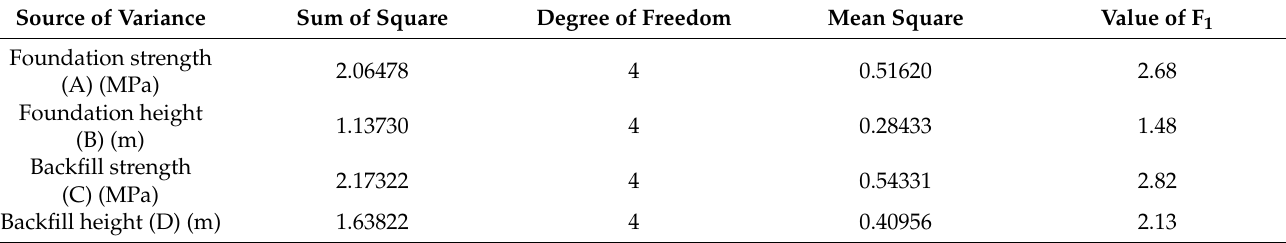
Table 6. The ANOVA of the safety factor of the underground backfill pillars obtained by the numerical simulation. Source of Variance